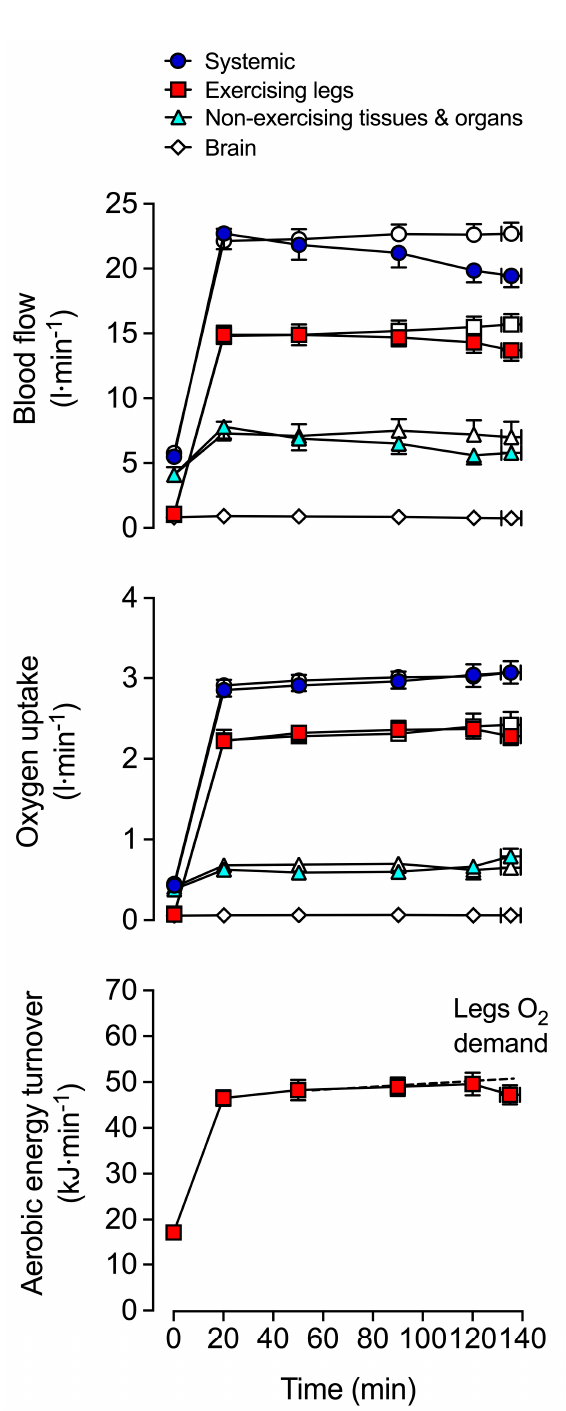
Figure 2. Effects of progressive dehydration and hyperthermia on blood flow, oxygen uptake and energy turnover during submaximal constant load cycle exercise compared to the control euhydration condition. Systemic and regional blood flow progressively decline, whilst oxygen uptake ( V O 2 ) and legs aerobic energy turnover are maintained during prolonged submaximal cycling (~60% V O 2max ) with dehydration and hyperthermia to exhaustion compared to control euhydration (corresponding blank symbols) in trained individuals. The dotted line indicates the legs O 2 consumption (demand) in the control trial. Adapted from Gonz á lez-Alonso et al.